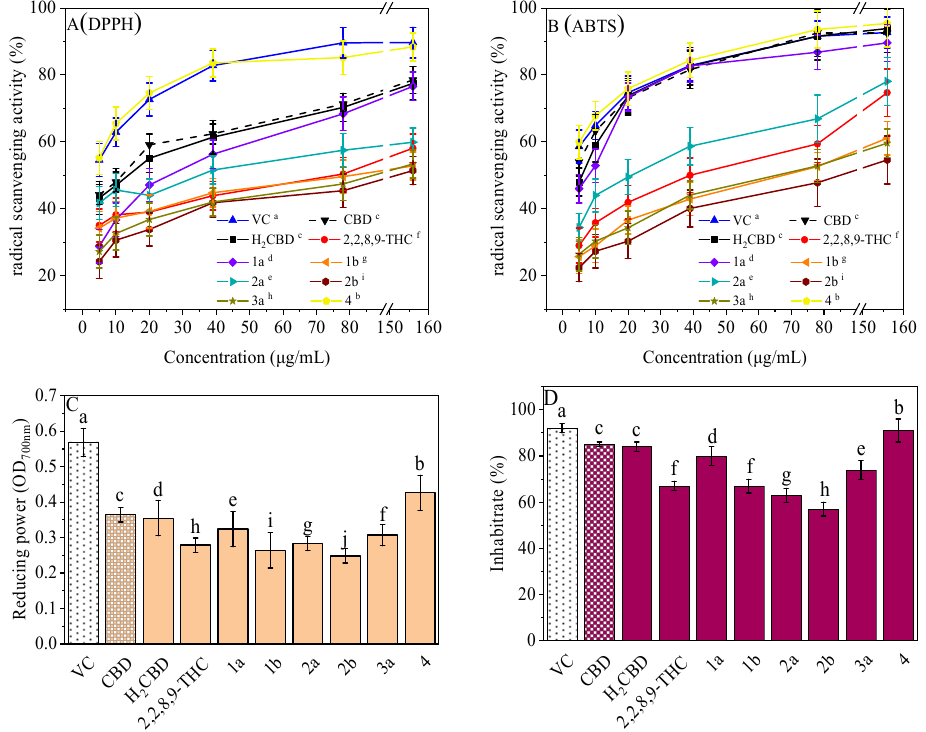
Figure 5. Antioxidant activities of the H 2 CBD with other antioxidants. DPPH ( A ), ABTS ( B ), FRAP ( C ), Lipid oxidation inhibition ( D ). Data are expressed as mean SD (n = 3). Different letters indicate statistically significant difference according to Duncan’s test at the significance level ( p < 0.05).